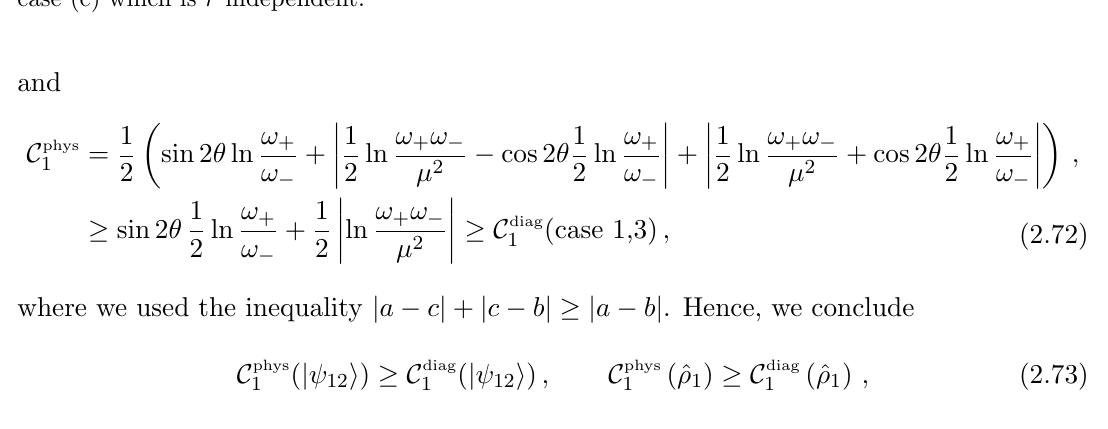
Figure 4 . Puri(cid:12)cation complexity of one-mode Gaussian states in the physical basis C phys function of (cid:11) for some (cid:12)xed values of (cid:22) r . The fact that the curves with (cid:22) r = (cid:0) 6 and (cid:22) r = (cid:0) 10 coincide after a certain value of (cid:11) is due to the fact that this minimization is obtained at the minimum of case (c) which is (cid:22) r